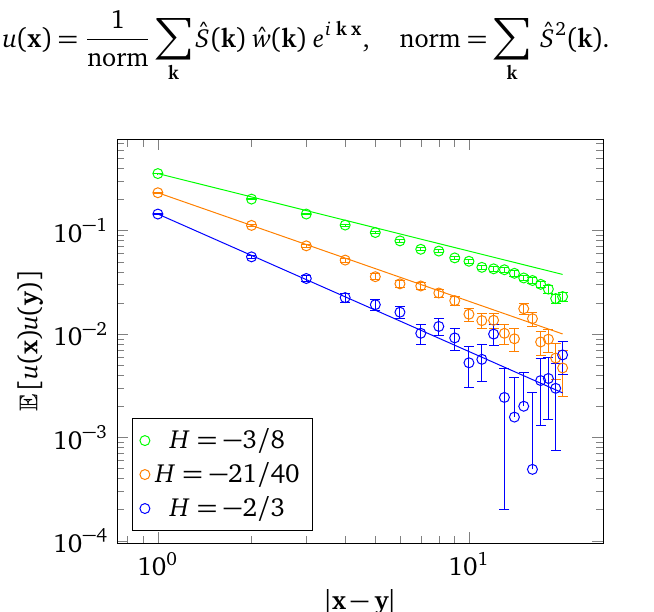
Figure 17: Numerical measurement of (cid:69) [ u ( x ) u ( y )] for different values of the Hurst exponent, on square lattices of size M = N = 2 8 . The lines have slopes − 2 H